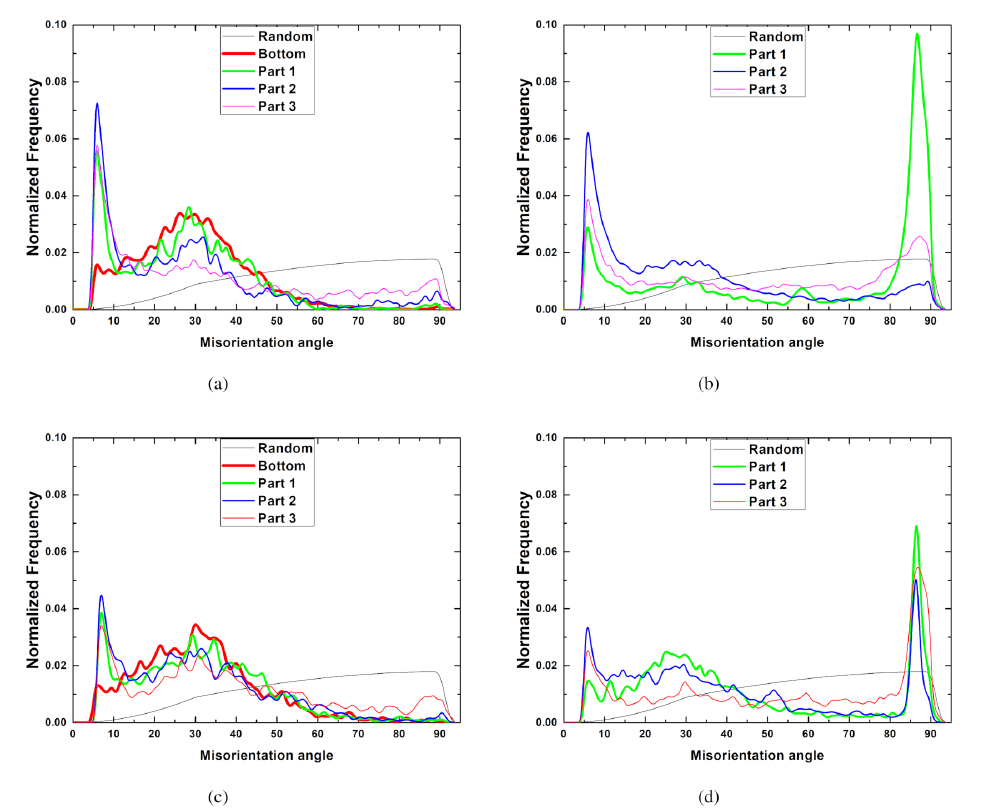
Figure 17. Frequency of misorientation distribution at various positions of drawn cups (IC sheets). Deformation rates and temperatures: ( a ) 30 mm/min, and ( b ) 50 mm/min at 225 ◦ C, and ( c ) 30 mm/min, and ( d ) 50 mm/min at 350 ◦